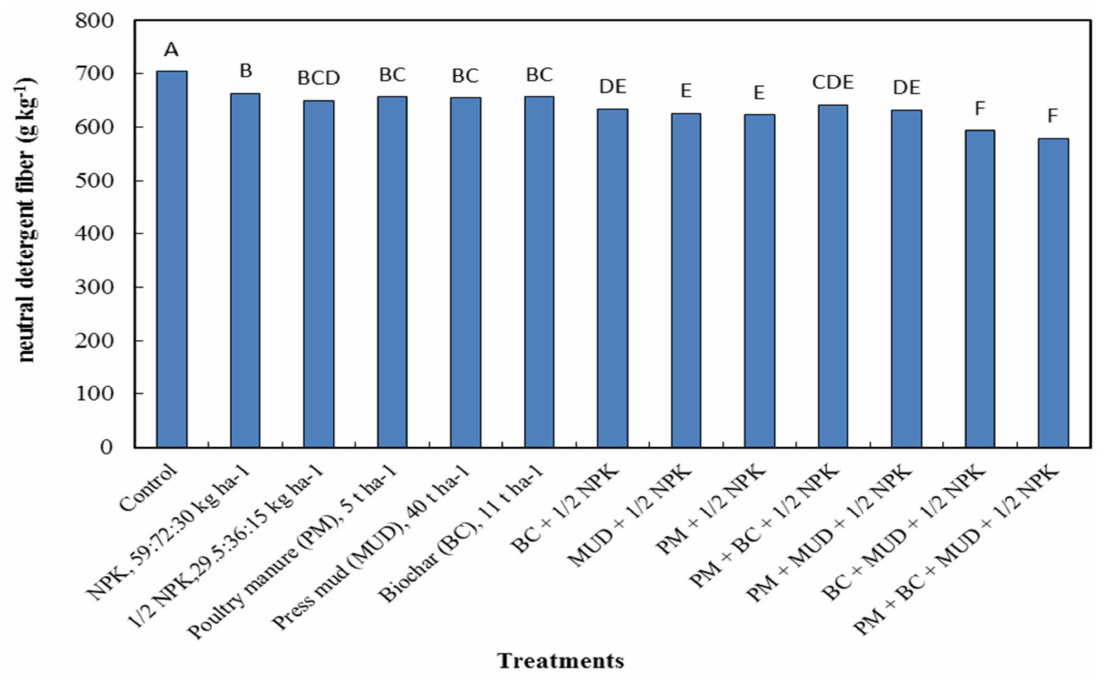
Figure 2. Effect of organic and inorganic amendments on neutral detergent fiber of forage sorghum under the field conditions of Layyah, Pakistan. Values are the means of two years and three replicates. Means with similar letters at the top of the bar did not differ significantly at p ≤ 0.05 (HSD = 20.9).